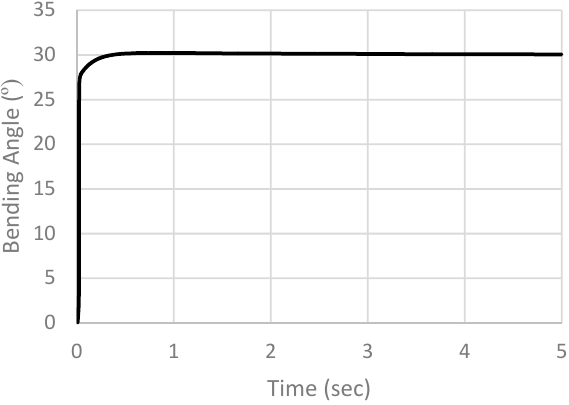
Figure 24. Simulation results of PI controller with Kp = 1.5, Ki = 0.5. After the first simulation, a concentrated force is added at the tip of the actuator to simulate the finger’s resistance to the actuator, as shown in Figure 25. The job is resubmitted, and results are extracted. Figure 26 shows the results of simulation. From the simulation results we notice that tr = 0.24594 s, ts (5%) = 0.3684 s and ts (2%) = 0.502 s.